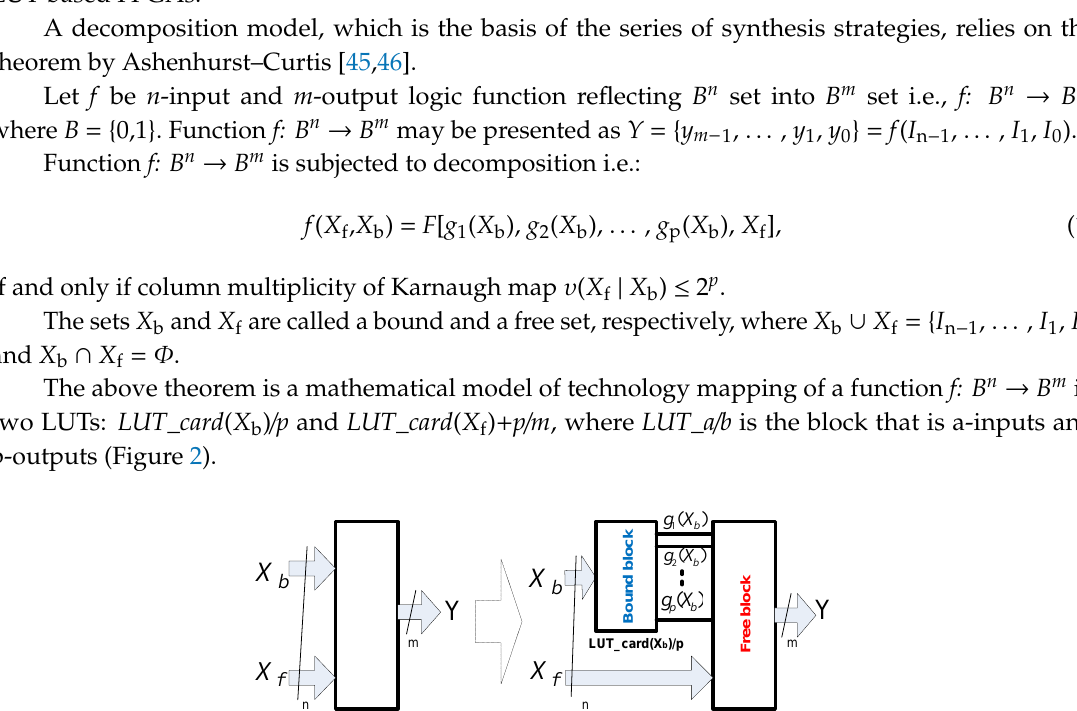
Figure 2. The idea of serial decomposition.